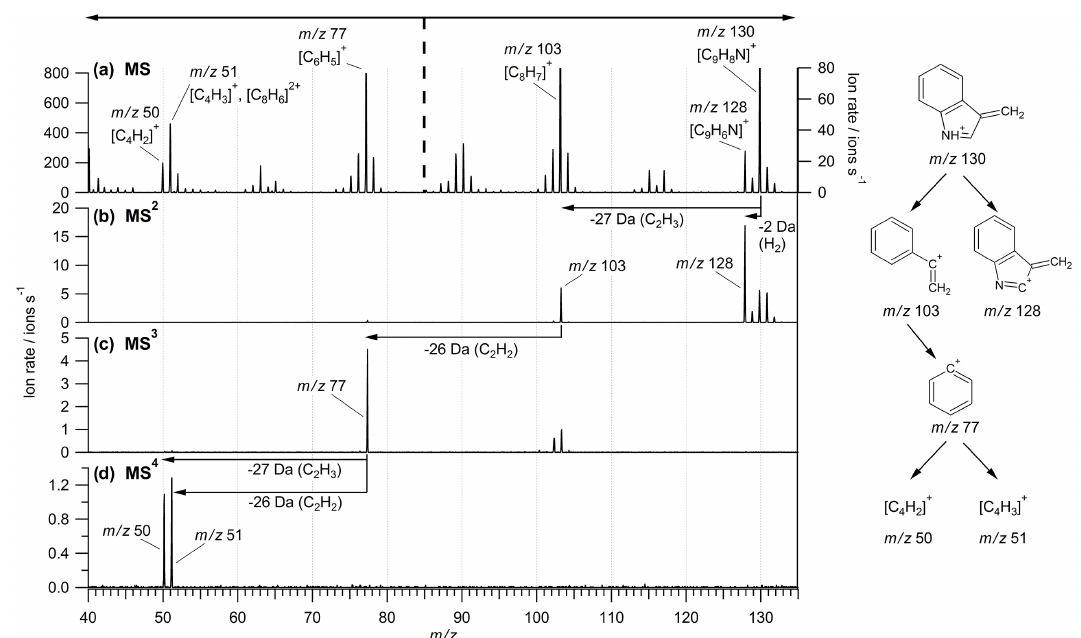
Figure 5. MS 4 study on tryptophan. Shown are the “classic” MS (a) and mass spectra acquired after isolating and fragmenting m/z 130 (MS 2 , b ), m/z 103 (MS 3 , c ), and m/z 77 (MS 4 , d ) from the respective previous step. The dashed vertical line in panel (a) divides the m/z ranges for which the left/right y axes are used,